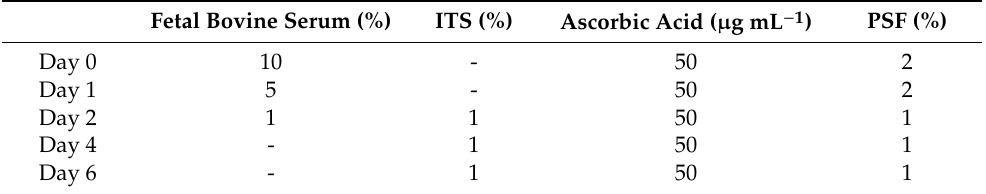
Table 2. Timetable of progressive substitution of serum for ITS in the cell-agarose construct.